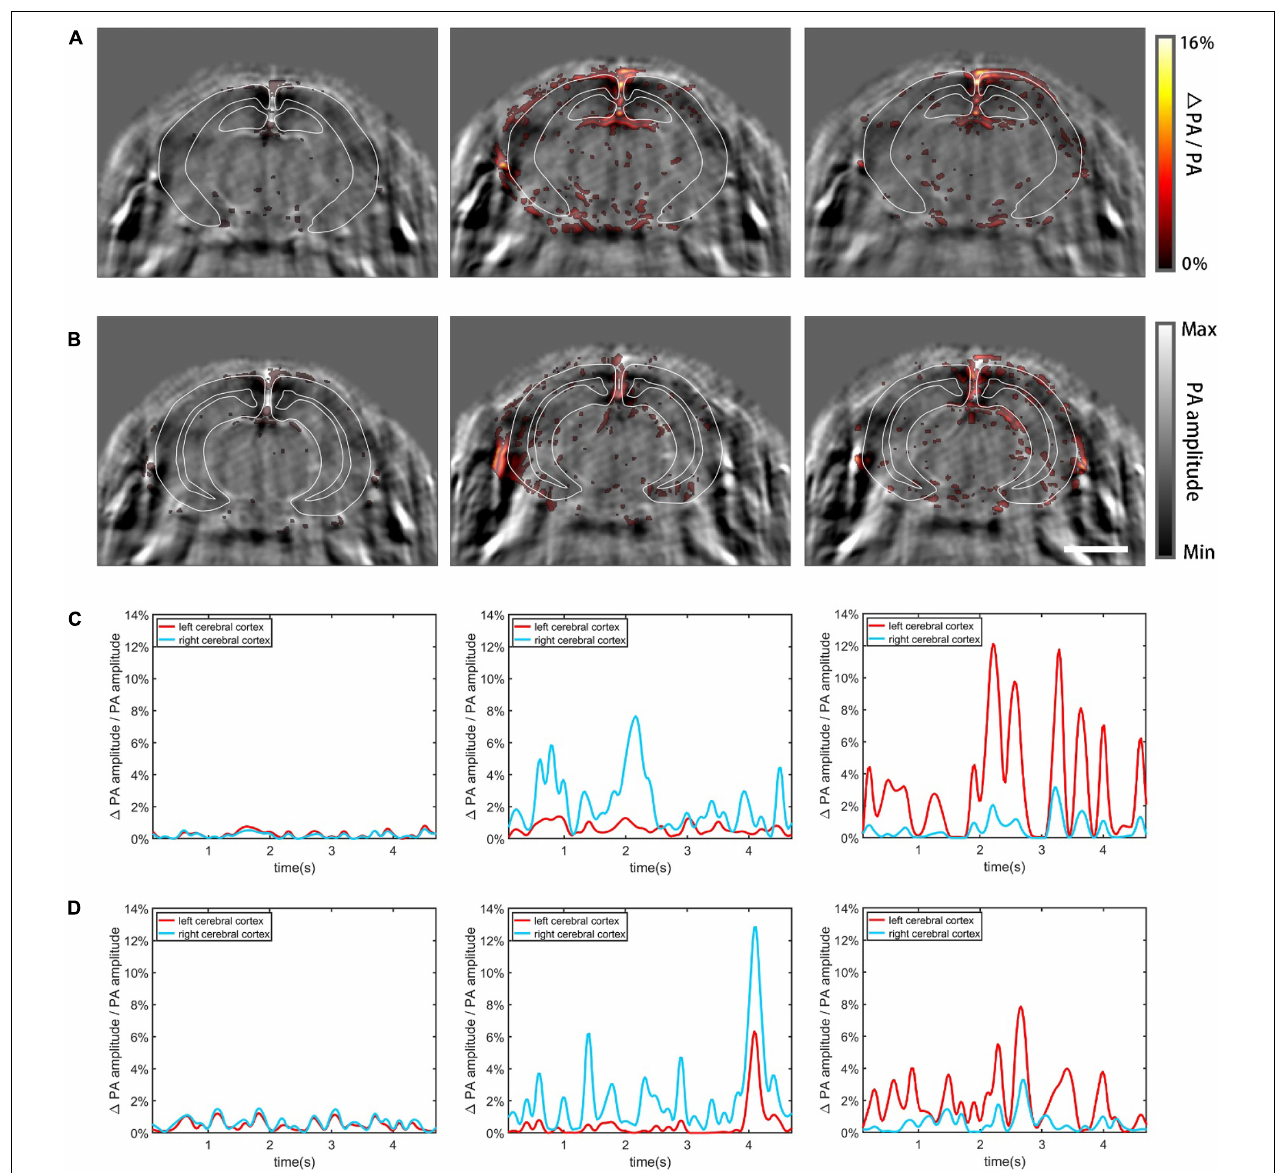
FIGURE 8 | Functional cerebral hemodynamic PACT imaging results. The functional hemodynamic changes are in pseudo-color and the structural images are in grayscale as background. (A) Functional PACT images of the midbrain corresponding to: no external stimulation (left), left forepaw stimulation (middle), and right forepaw stimulation (right). (B) Functional PACT images of the hindbrain in the three cases as in panel (A) . (C) Relative change of the total signal in the midbrain cerebral cortex corresponding to the three different cases as in panel (A) . (D) The same plots as in panel (C) for the hindbrain. Scale bar = 3